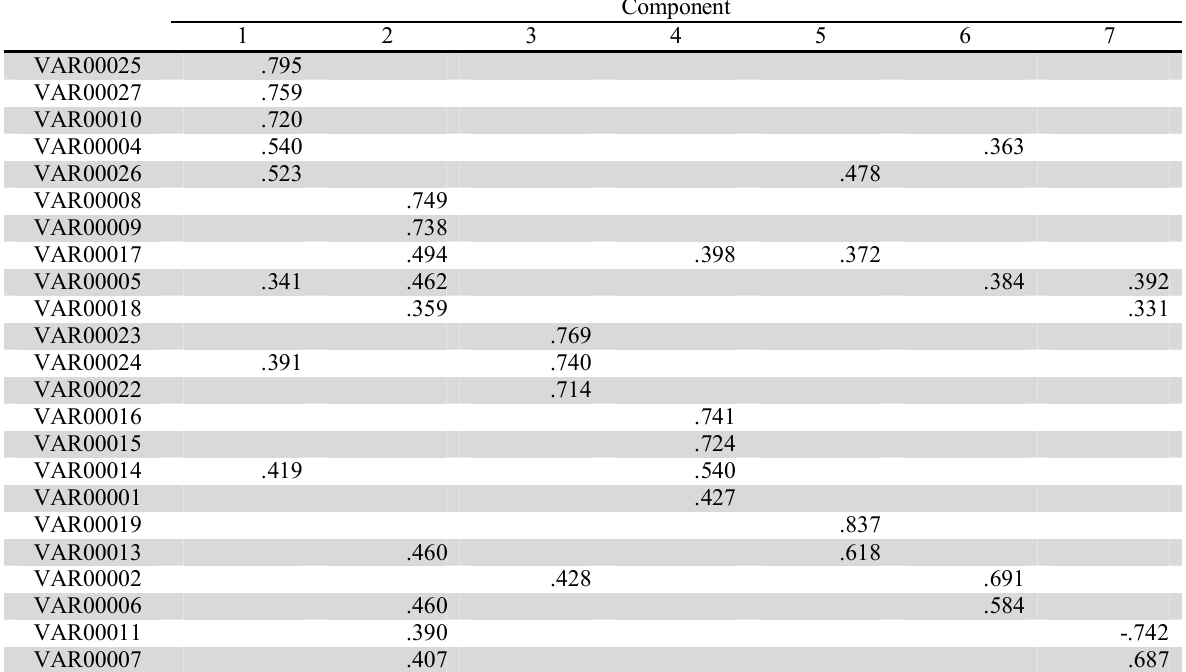
The summary of principal component analysis after rotation